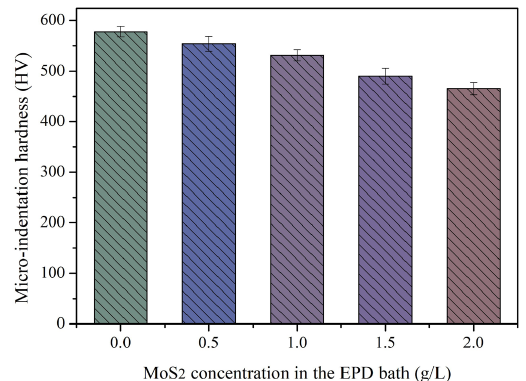
Figure 7. Micro-indentation hardness of the composite coatings.